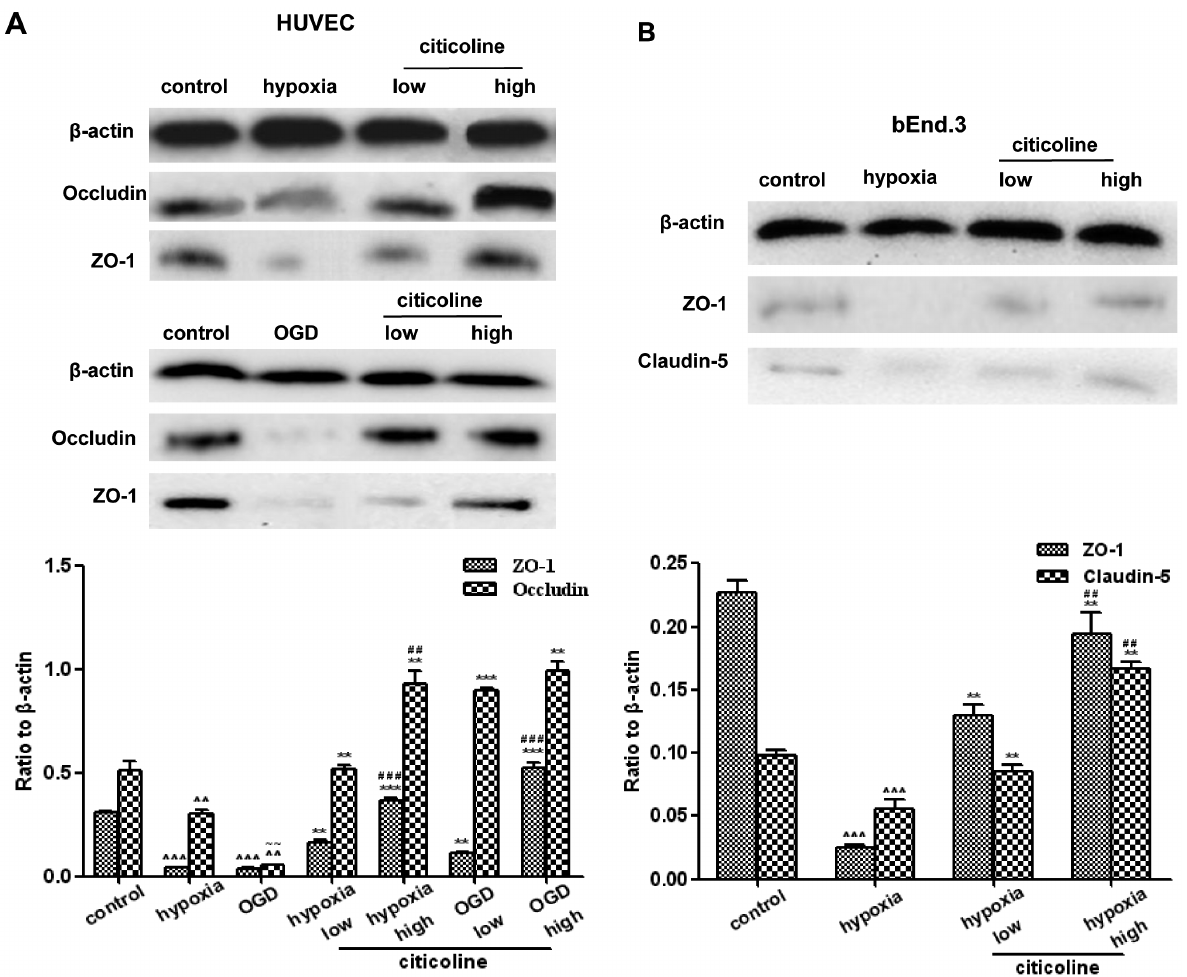
Figure 4. The effects of citicoline on Hypoxia/OGD induced changes in the protein expression of TJPs in endothelial cells. ( A ) Protein levels of ZO-1and occludin in HUVECs. ( B ) Protein levels of ZO-1 and claudin-5 in bEnd.3s. Both high and low dose of citicoline increase the expression, while high-dose is more effective when compared to low dose.ˆˆ P , 0.01,ˆˆˆ P , 0.001 vs. control; * P , 0.05, ** P , 0.01, *** P , 0.001 vs. model; ## P , 0.01, ### P , 0.001 vs. low citicoline; ,, P , 0.01 vs. hypoxia,